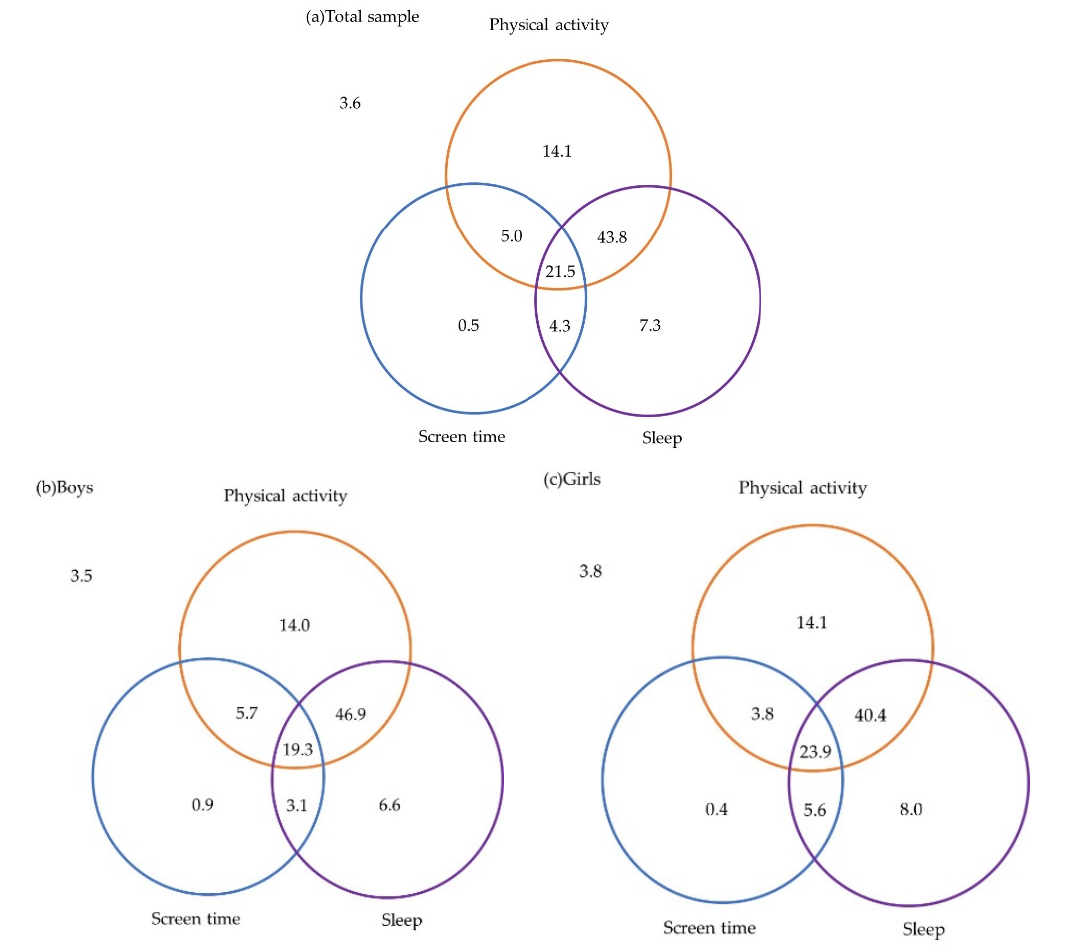
Figure 1. Percentages meeting 24-h movement guidelines among ( a ) overall ( n = 421), ( b ) boys ( n = 216) and ( c ) girls ( n = 199) Japanese preschool children. Venn diagram: The numbers within each circle are added to the proportion of children meeting each individual guideline (i.e., 65.4% for physical activity, 88.2% for screen time and 29.5% for sleep duration). The total nonoverlap area of each circle represents the proportion of children meeting one of the three guidelines (i.e., 6.0% + 18.9% + 1.6% = 26.5%). The total overlap areas of two circles represents the proportion of children meeting two guidelines of the three guidelines (i.e., 42.9% + 1.5% + 11.4% = 55.8%). The overlap area of three circles represents the proportion of children meeting all three guidelines (i.e., 15.0%). The outside area of the circle represents the proportion of children not meeting any of the guidelines (i.e., 2.7%). Table 2 outlines the association between the BMI z-score and 24-h MG combinations using logistic regression analysis adjusted for sex and age. Compared to children who adhered to all three 24-h MG, those who did not adhere to the 24-h MG were more likely to be overweight or obese (odds ratio 1.139, 95% confidence interval: 1.009,